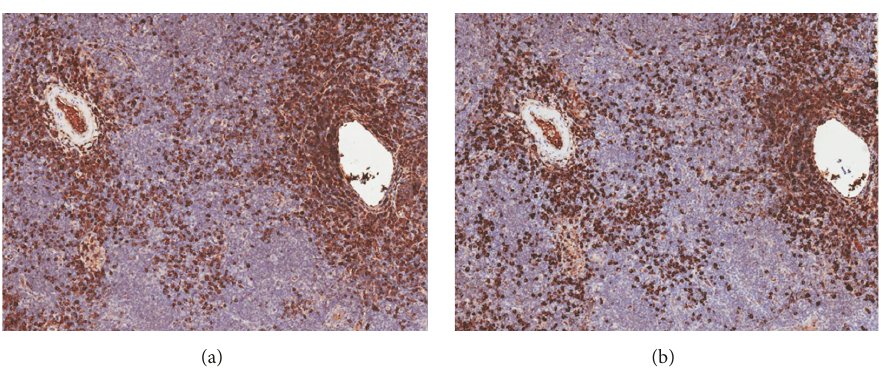
Figure 2: Immunostaining for IgG (a) and IgG4 (b) from submandibular gland/lymph node biopsy.